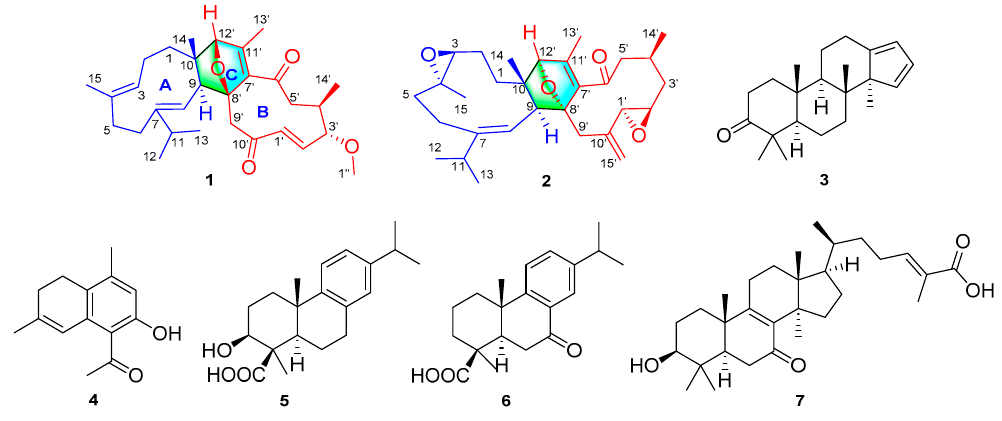
Figure 1. The structures of compounds 1 – 7 .